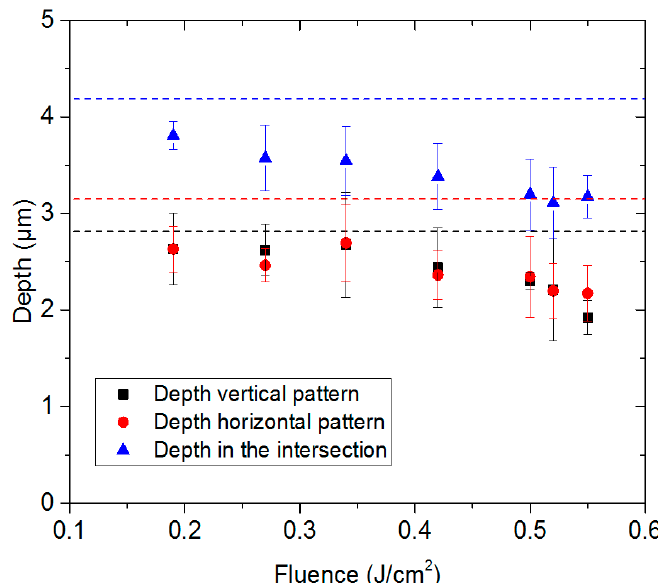
Figure 4. ( a ) Depth of ps-DLIP pillar-like microstructures as a function of the laser fluence used in the post-process by nanosecond laser pulses. The dashed lines denote the mean depth of the untreated multi-scale pillar-like structures at the vertical (black line), horizontal (red line) and intersection points (blue line). Each data point was an average of ten depth measurements, the error bars were estimated by the standard deviation.